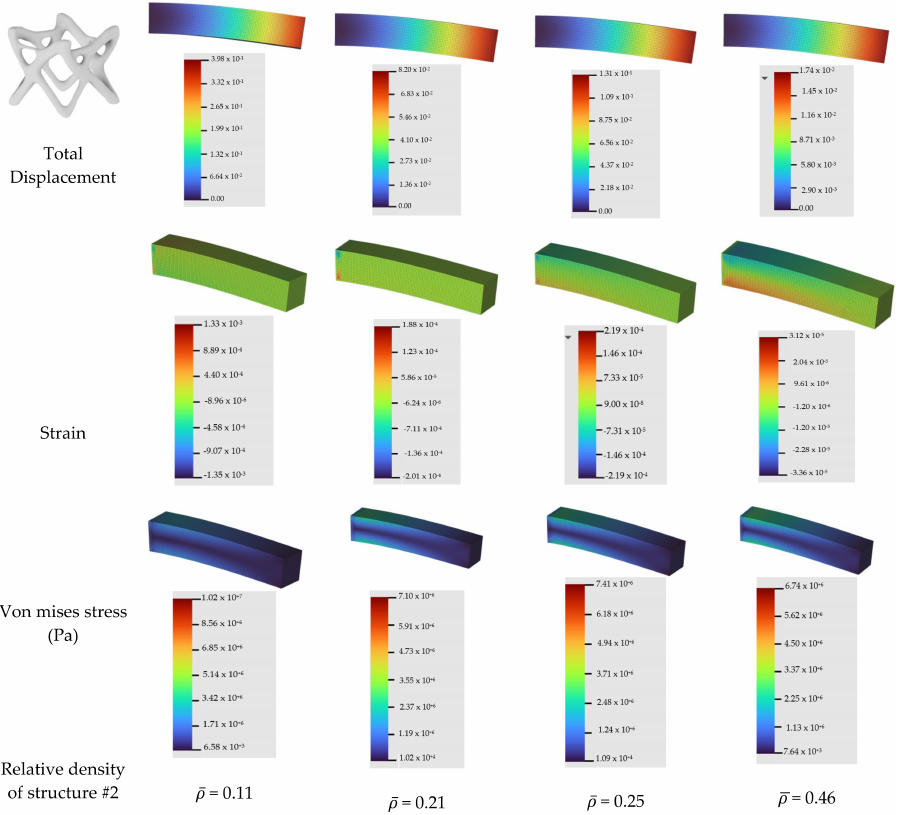
Figure 17. Displacement, strain and Von mises stress of homogenized structures #1 and #2 for different values of relative